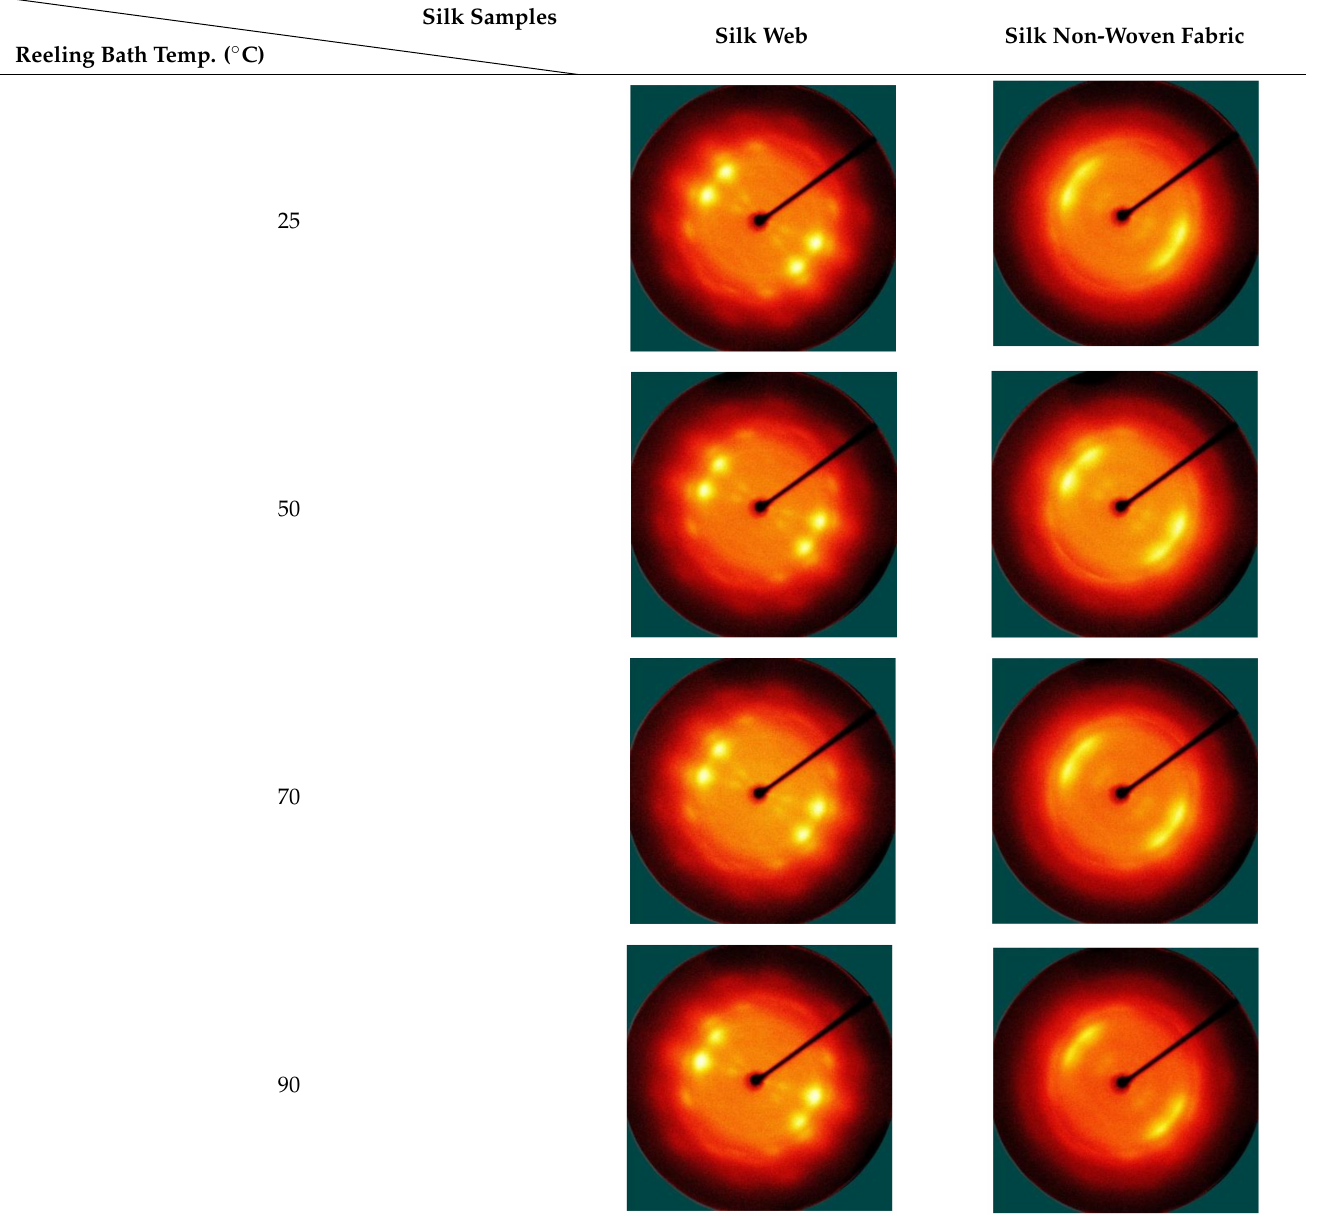
Table 5. X-ray fiber diffraction patterns of silk web and silk non-woven fabrics prepared at various reeling bath temperatures. Reeling velocity was 39.2